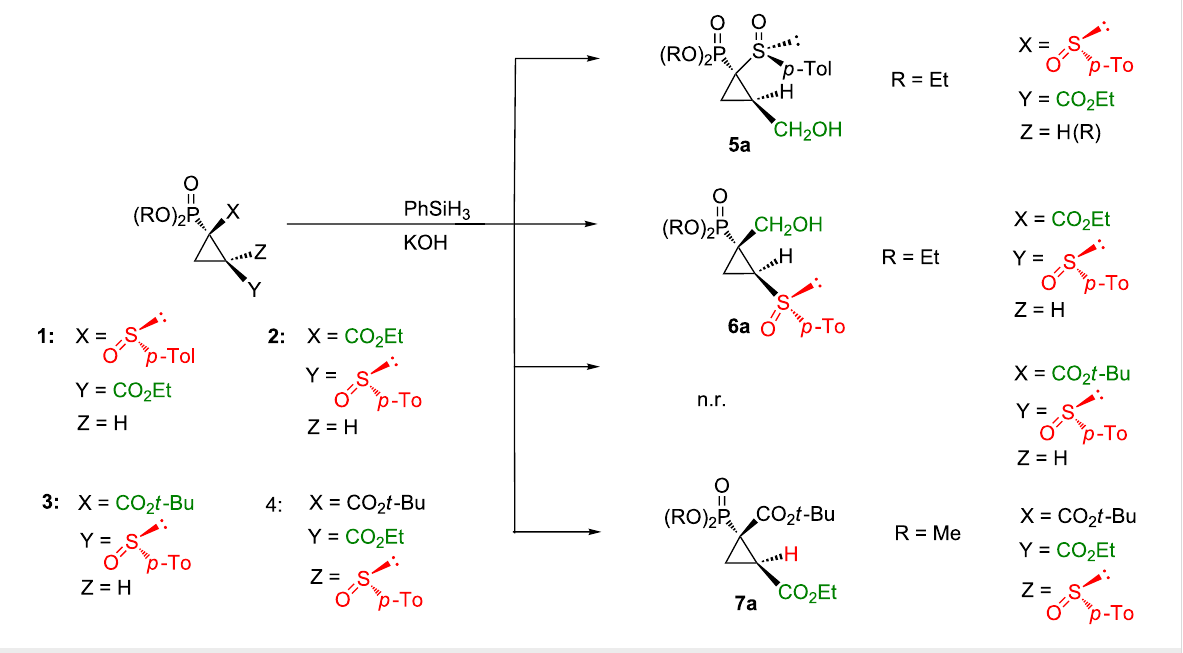
Scheme 1: Different behaviour of cyclopropylphosphonates in the reaction with